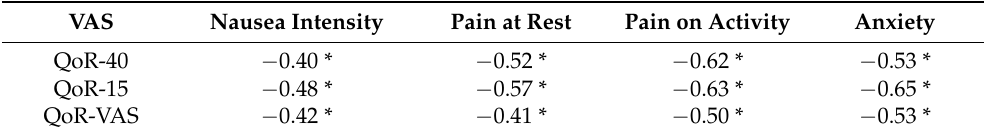
Table 3. Correlational analysis of secondary